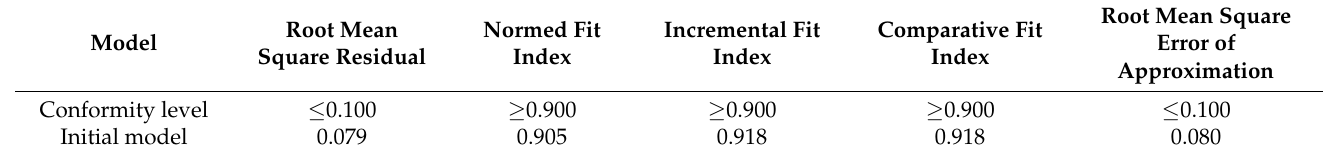
Table 12. Goodness-of-fit of the path model.